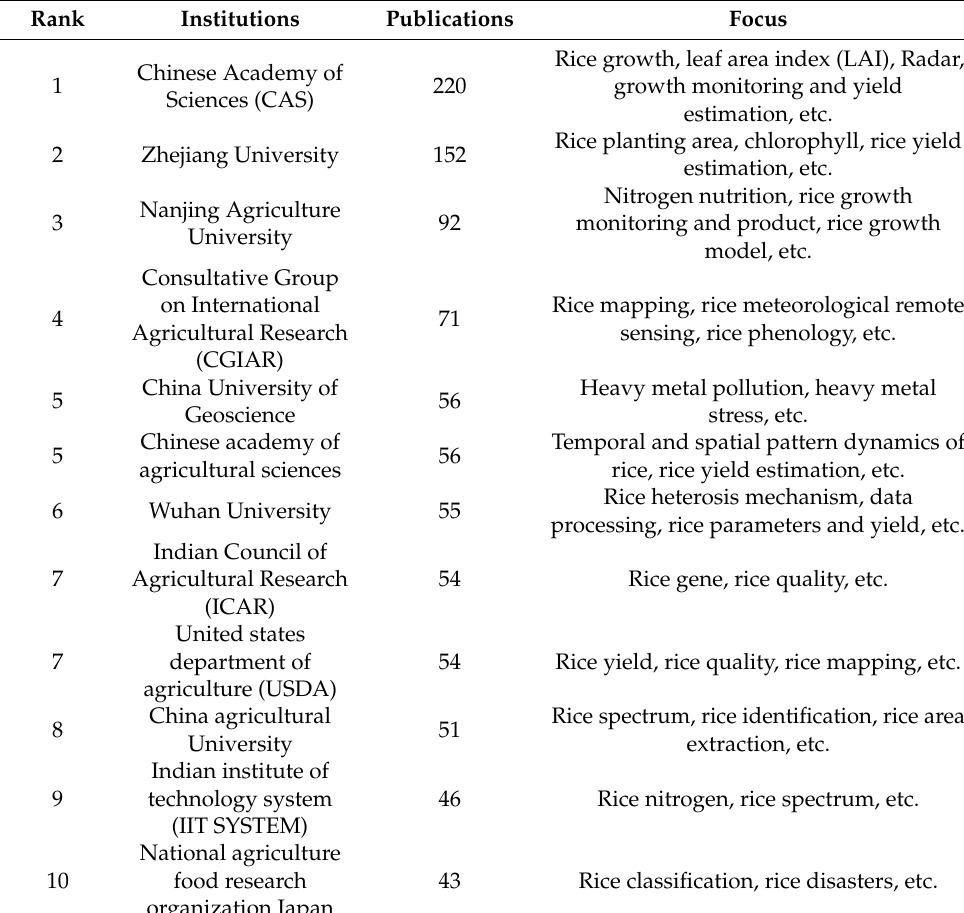
Table 3. Statistics of the publications and research attentions of core research